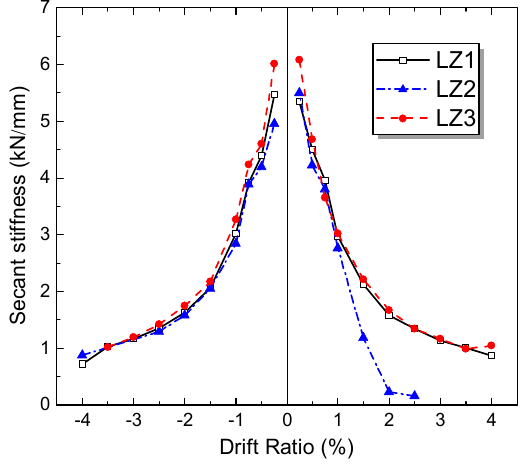
Figure 10. Secant stiffness degradation.